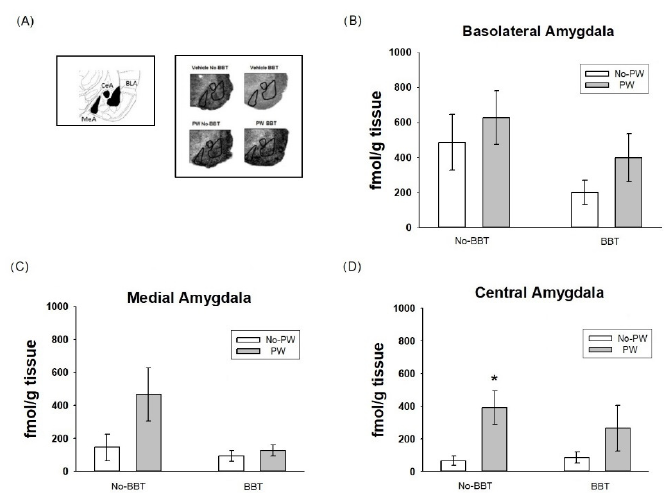
Figure 4. Representative images of autoradiographic slides from the [3H]Flunitrazepam binding observed in amygdala nuclei ( A ) Effect of progesterone withdrawal (PW) on [3H]Flunitrazepam binding in basolateral ( B ), medial ( C ), and central ( D ), amygdala Wistar Kyoto rats (n = 4–6 per group). No ‐ BBT = not tested in the burying behavior test; BBT = tested in the burying behavior test. Each bar represents the mean value ± standard error of the mean. * p < 0.05 vs. No ‐ PW.